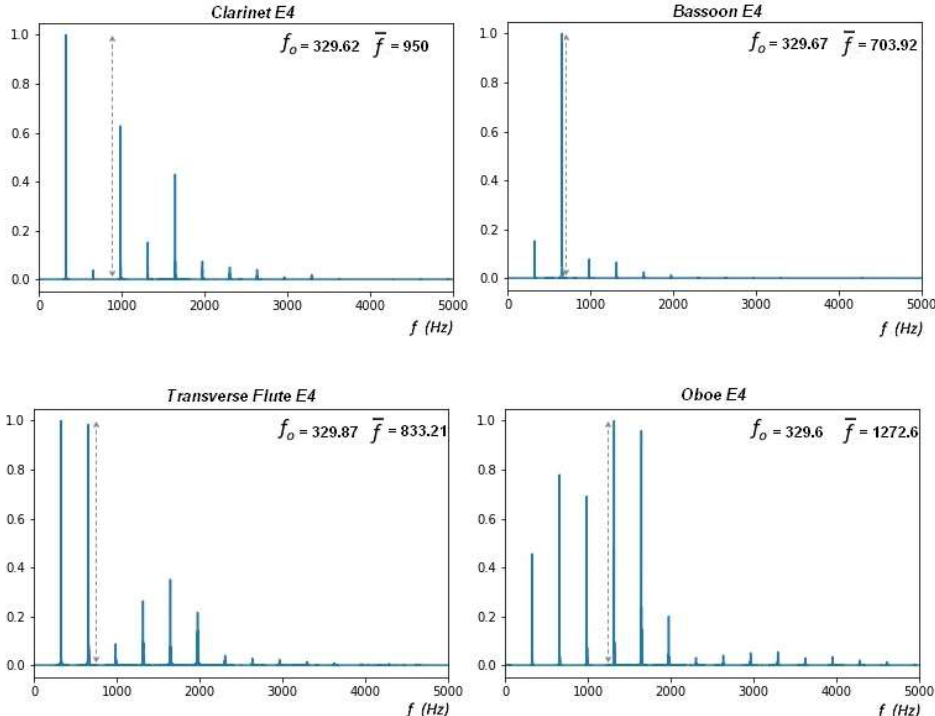
Figure 1. FFT spectra for the aerophones studied. Note that in each instrument the centroids (dotted line) do not coincide with any of the frequencies in the distribution and are not directly linked to the musical sound E4 of nominal frequency 329.6 Hz.